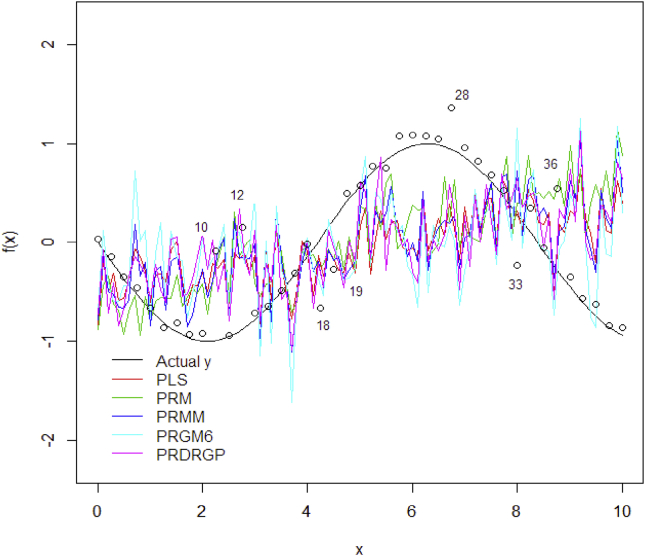
Predictions on testing data using training model of non-kernel methods.